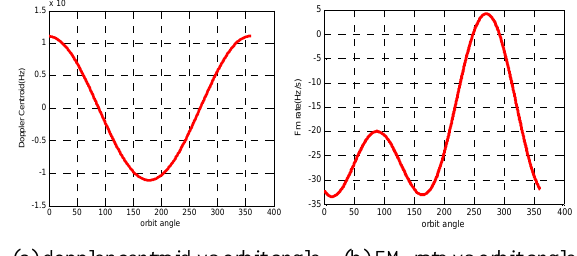
Figure 3. Doppler varied vs Argument of latitude Figure 4. Beam steering of the different SAR